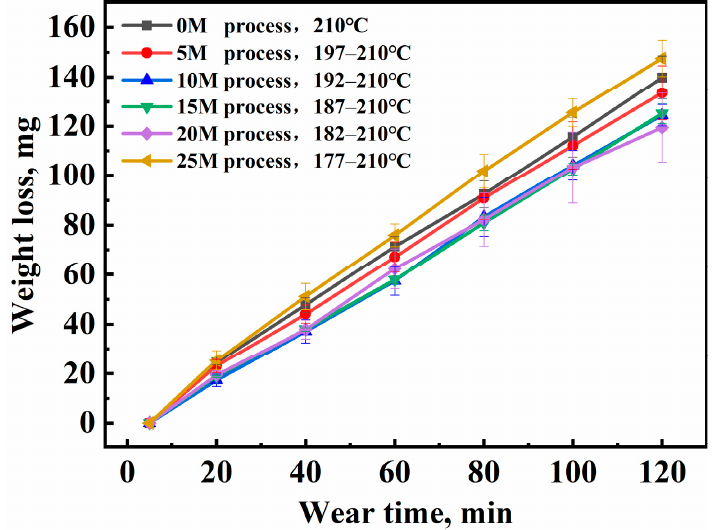
Figure 7. Relationship between weight loss and wearing time of specimens with different treatment processes.